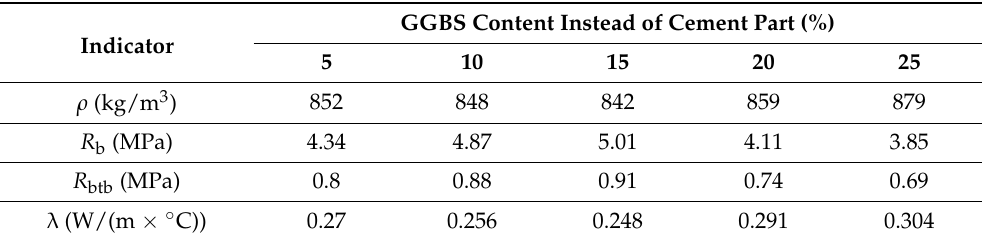
Table 11. Physical and mechanical characteristics of samples of non-autoclaved aerated concrete modified with FA. Table 12. Physical and mechanical characteristics of non-autoclaved aerated concrete modified with GGBS.